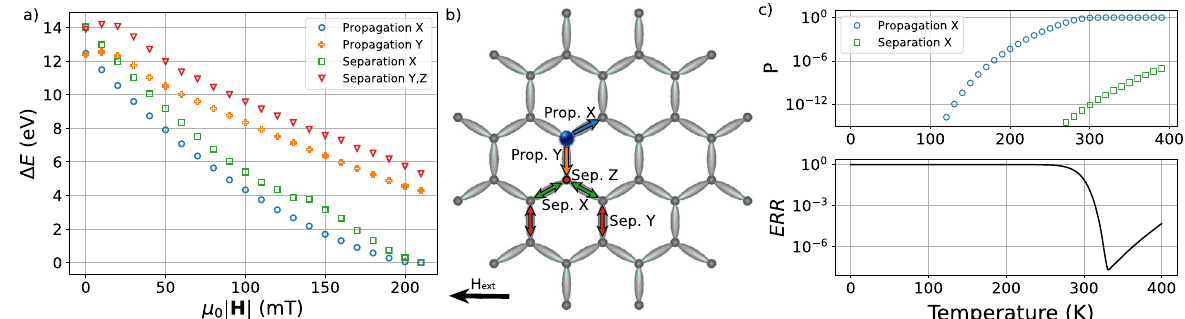
Fig. 3 Arbitrary fi eld fi nite temperature micromagnetic analysis. a Dependence of the energy barrier on the applied external fi elds at T = 0 K to switch the magnetizations of different ellipsoids as depicted in ( b ). c Upper panel: the switching probability P at different temperatures for the relevant transitions from ( b ) calculated with FTM analysis, Eq. (3), where a Zeeman fi eld with μ 0 ∣ H ∣ = 180 mT, attempt frequency f 0 = 50 GHz and pulse time t fi nal = 0.15 ns were chosen. Lower panel: mean error rate of successful propagation correlated with the unintended separation, as given by Eq.